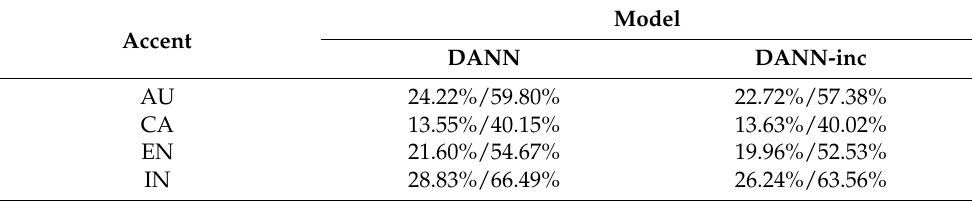
Table 6. Performance (CER/WER) of DANN models by adding more target domain